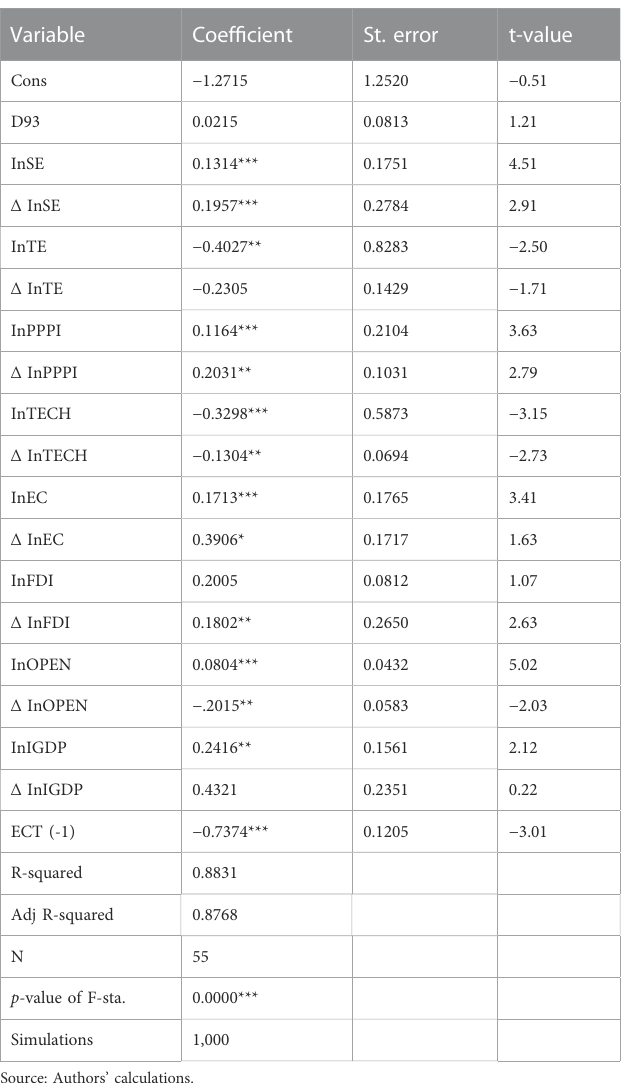
TABLE 11 Dynamic ARDL simulations